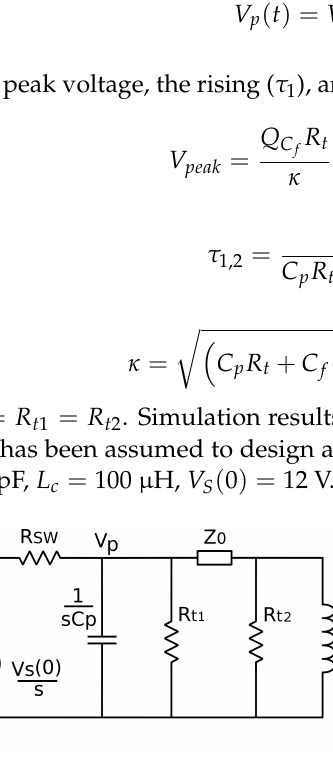
Figure 1. Equivalent s-domain model of the charge